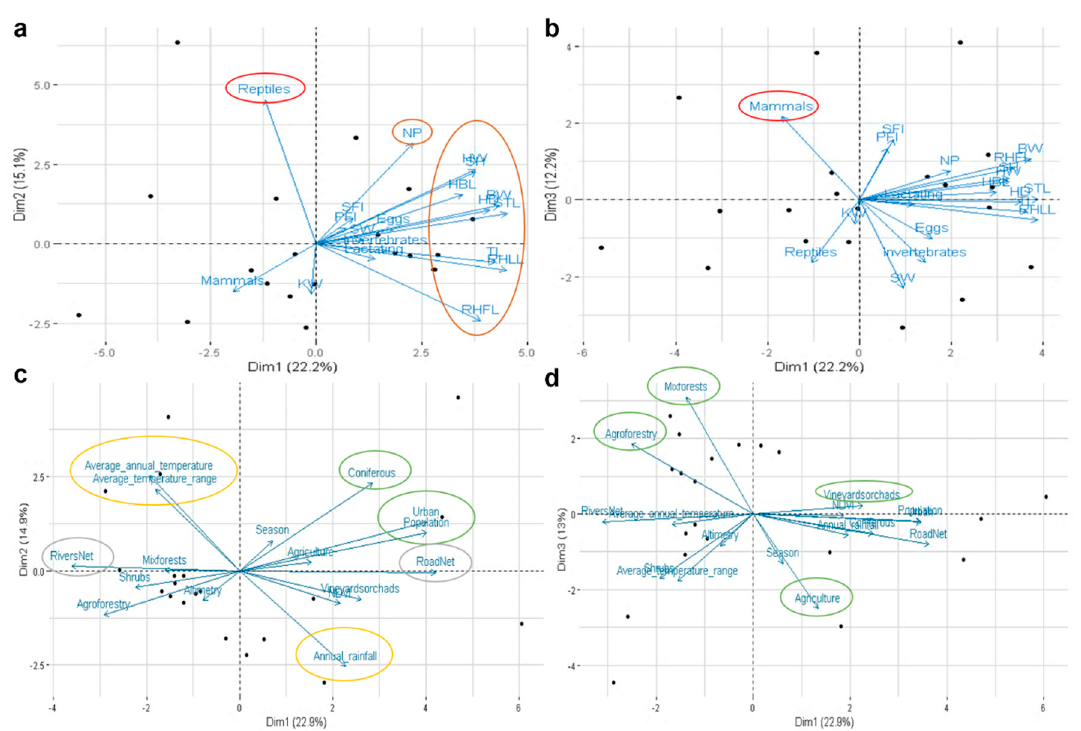
Figure 4. Interaction between bacterial gut microbiota and biotic and abiotic factors of Egyptian mongoose. Principal Component Analysis using: ( a , b ) biological variables related to stomach content at the time of death and different body measurements; ( c , d ) environmental variables related to land-use, and climatic, topographic, and population data. The more influential factors are delimited using different colors—red: stomach content; brown: biometric data; green: land-use; yellow: climatic data; grey: topographic data. BW: body weight; STL: snout-tail length; TL: tail length; HBL: head and body length; RHLL: right hind leg length; RHFL: right hind foot length; SH: shoulder height; NP: neck perimeter; HD: head diameter; HW: head width; SW: spleen weight; KW: kidney weight; SFI: solid fat index; PFI: perivisceral fat index.